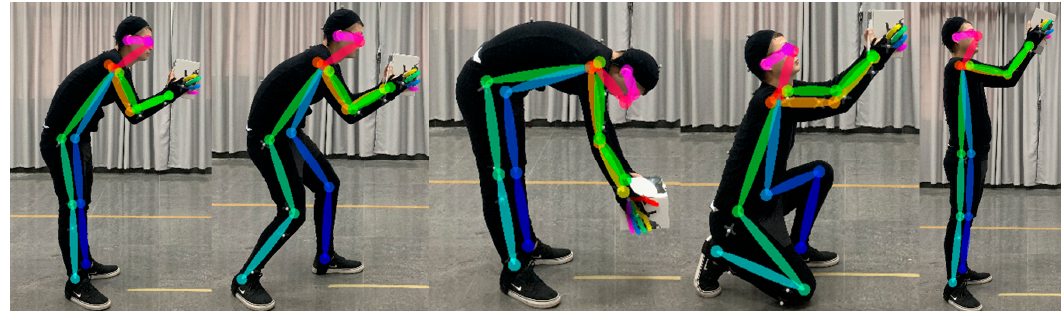
Figure 9. Human skeleton generated by Quick Capture system.